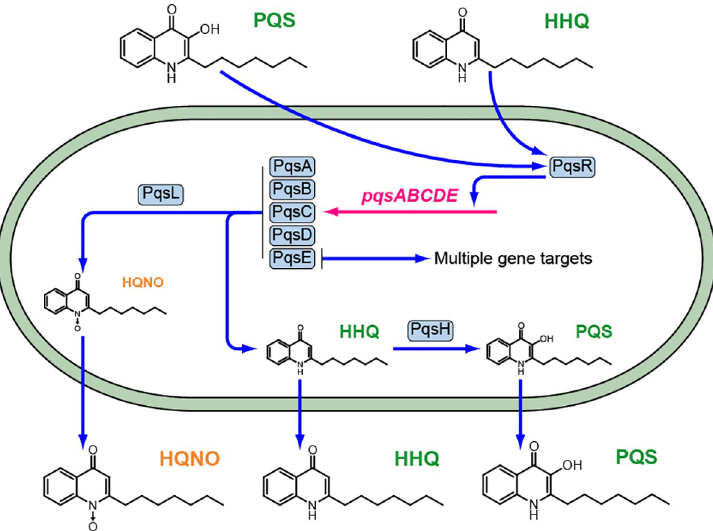
Fig 1. The PQS signalling pathway in P . aeruginosa . The PqsABCDE proteins synthesize HHQ, which is converted to PQS by PqsH and also HQNO in conjunction with PqsL. Both HHQ and PQS are released by the cells into the extracellular environment and are taken back up by neighboring cells. Autoinduction occurs when either HHQ or PQS binds to PqsR and amplifies expression of the pqsABCDE operon. The pqsE gene product has dual functions contributing to AQ biosynthesis as a thioesterase and also via an AQ-independent, thioesterase-independent mechanism for e.g. pyocyanin, rhamnolipid and lectin production as well as biofilm maturation. The conversion of HHQ to PQS confers additional functionalities since PQS unlike HHQ induces microvesicle formation and is a potent iron chelator.